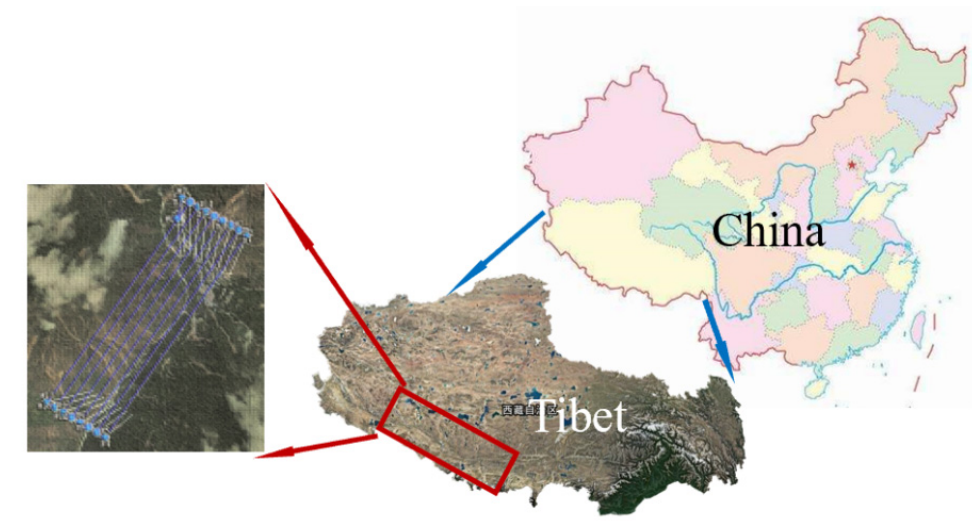
Figure 1. The red box represents the study area (The left figure shows the UAV route planning).